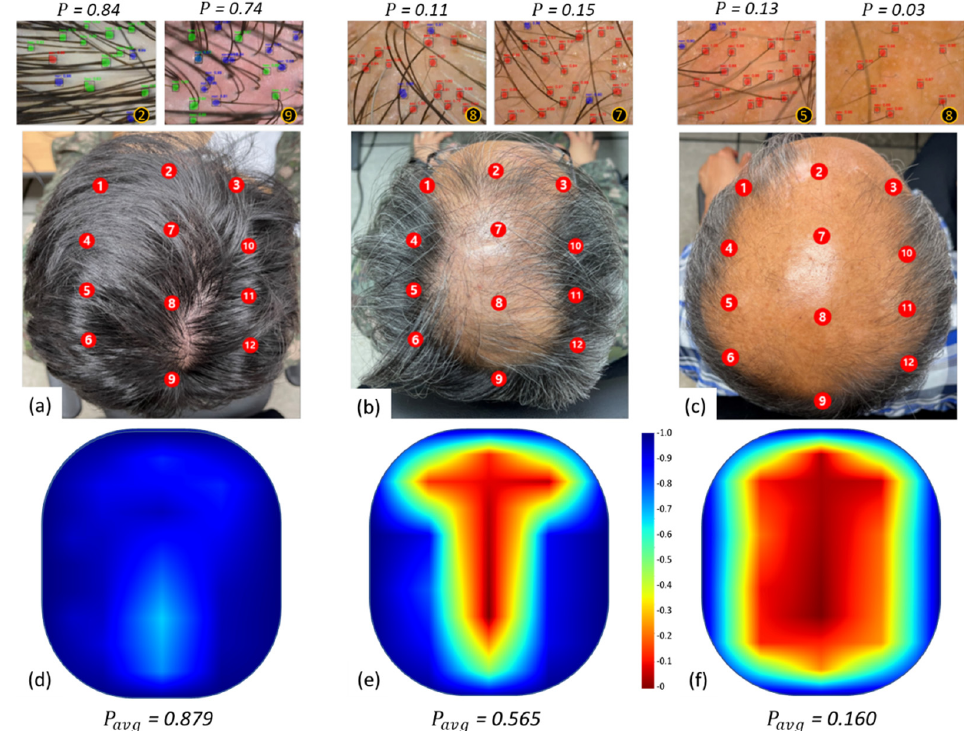
Figure 6. Representative top-view head photos and their respective hair loss severity heatmaps of the subject with the overall healthy state ( a , d ); moderate hair loss ( b , e ); and severe hair loss ( c , f ). On the top of the head photos, the local hair loss severity index P is presented with the images taken from different locations of the scalp. The hair loss severity estimation P avg for the healthy, moderate hair loss and severe hair loss is 0.879, 0565, and 0.160, respectively, reflecting a gradual decrease in the value as hair loss progresses.